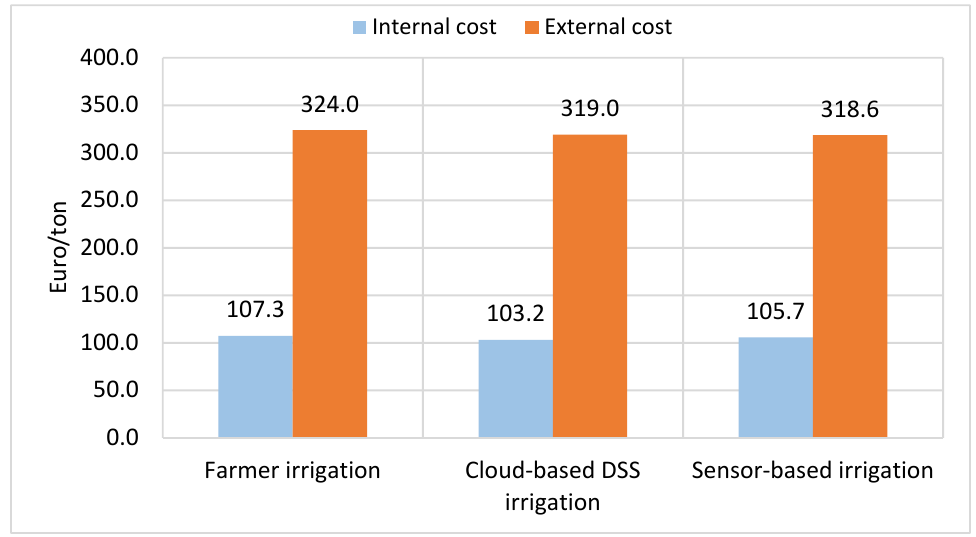
Figure 7. Total costs of irrigation management on zucchini cultivation including external environmental costs following the monetization of LCA results. Table 5. Effect of different parameters on life cycle cost (LCC) of Zucchini production per 1 ton of